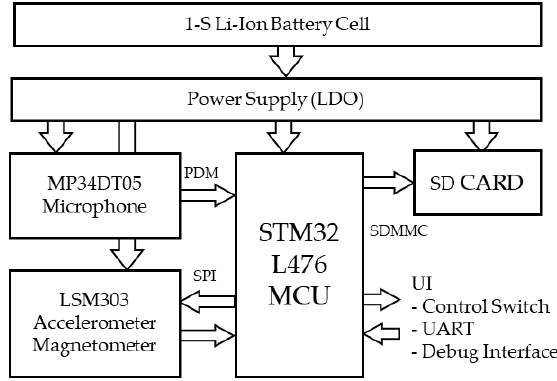
Figure 1. System